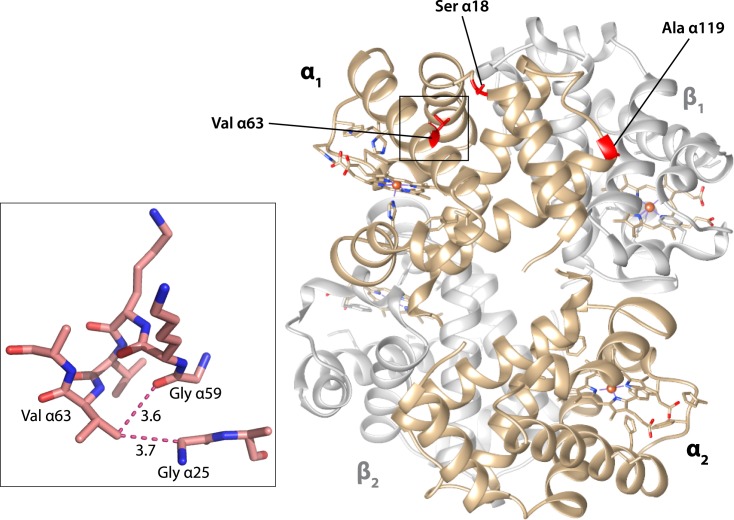
Structural model showing bar-headed goose Hb in the deoxy state (PDB1hv4), along with locations of each of the three amino substitutions that occurred in the bar-headed goose lineage after divergence from the common ancestor of other Anser species.The inset graphic shows the environment of the Val α63 residue. When valine replaces the ancestral alanine at this position, the larger volume of the side-chain causes minor steric clashes with two neighboring glycine residues, Gly α25 and Gly α59. The distances between non-hydrogen atoms (depicted by dotted lines) are given in Ǻ.